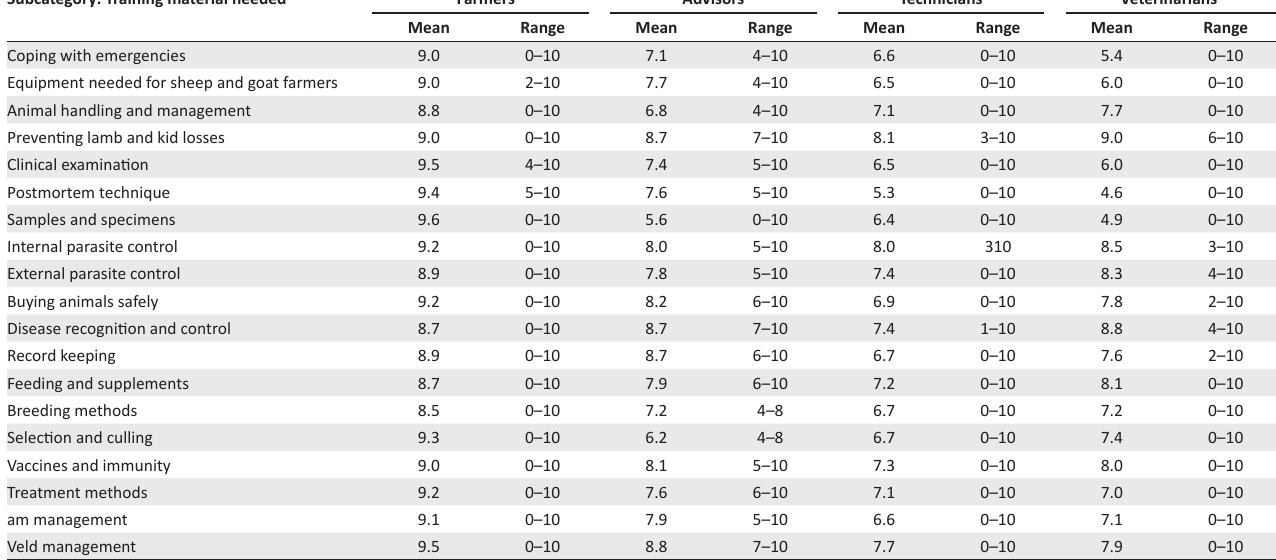
TABLE 11: Value rating of educational